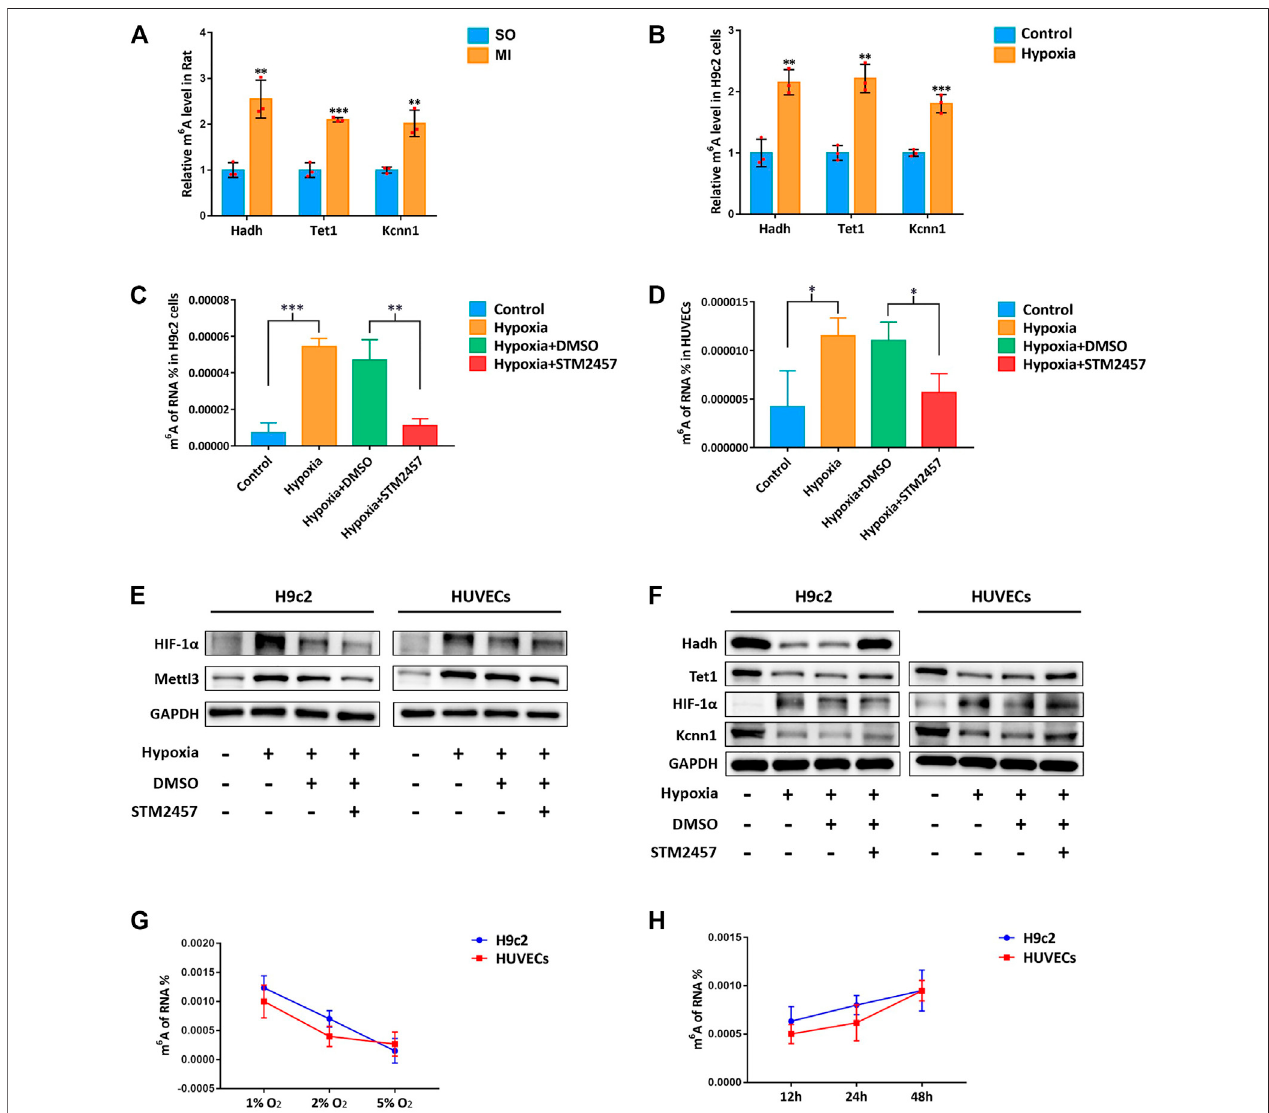
FIGURE 4 | m 6 A methylation in fl uenced by hypoxia in a time- and dose-dependent pattern. (A) MeRIP-qRT-PCR validation of hub mRNAs in MI rat; (B) MeRIP- qRT-PCR validation of hub mRNAs in H9c2 cells; (C) m 6 A methylation levels of H9c2 cells with Mettl3 inhibitor; (D) m 6 A methylation levels of HUVECs with Mettl3 inhibitor; (E) Mettl3 protein level of H9c2 cells and HUVECs with Mettl3 inhibitor. HIF-1 α was used as positive control. GAPDH was used as loading control; (F) protein level ofhub mRNAsin H9c2 cellsand HUVECs withMettl3 inhibitor; (G) m 6 A methylation levels ofH9c2 cells and HUVECs with different concentrationsofoxygen; (H) m 6 A methylation levels of H9c2 cells and HUVECs with different hypoxic duration. SO, sham operated; MI, myocardial infarction; DMSO, dimethyl sulfoxide. * p < 0.05, ** p < 0.01, *** p < 0.001. *STM2457 is the inhibitor of